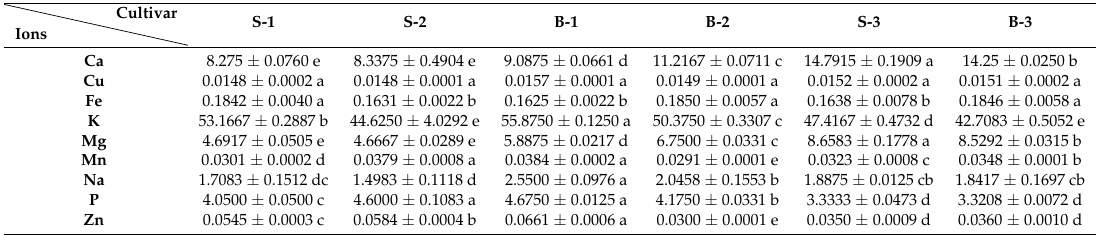
Table 2. The content of mineral elements composition (mg/g DW) in six red-lettuce leaves. Ions